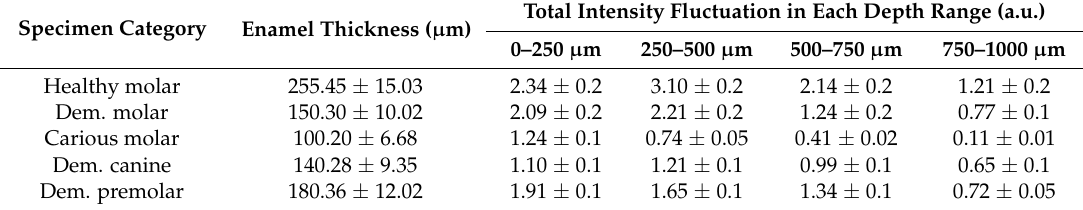
Table 3. The quantified enamel thickness and depth direction total intensity fluctuations.